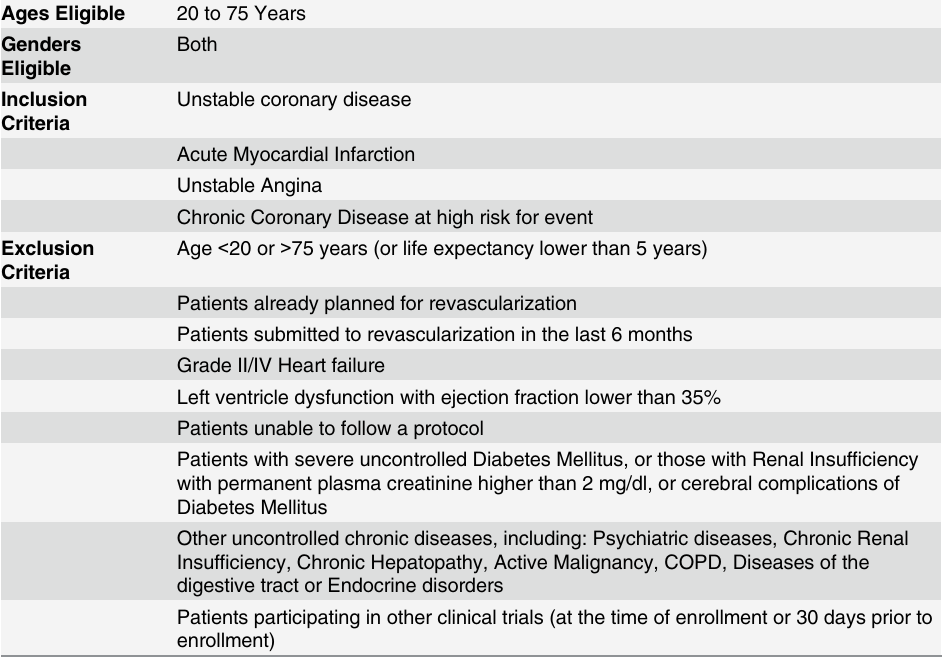
Table 1. Inclusion and exclusion criteria for CORDIOPREV